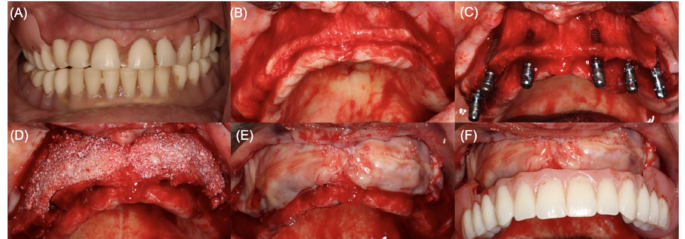
Figure 3. Clinical photographs of sequential surgical stages: ( A ) Atrophic maxilla of a partially edentulous patient who wore a removable prosthesis for more than 15 years; ( B ) Incision and full-thickness flap releasing. Note the thin buccal plate; ( C ) Implant placement. Note the buccal fenestration of the implants in the pre-maxilla; ( D ) Guided bone regeneration with a composite PRF/particulate xenograft to reconstruct the buccal aspect of the maxilla; ( E ) Overlay of the composite PRF/particulate xenograft with at least four PRF membranes, providing protection of the grafted area; ( F ) Full-arch implant-supported provisional restoration placed after